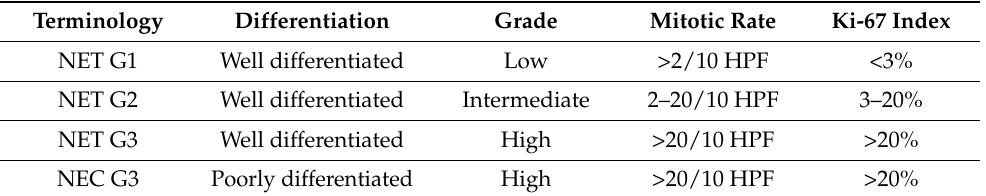
Table 1. Classification and grading criteria for pancreatic neuroendocrine neoplasms according to the WHO Classification of Tumors of Endocrine Organs, fourth edition